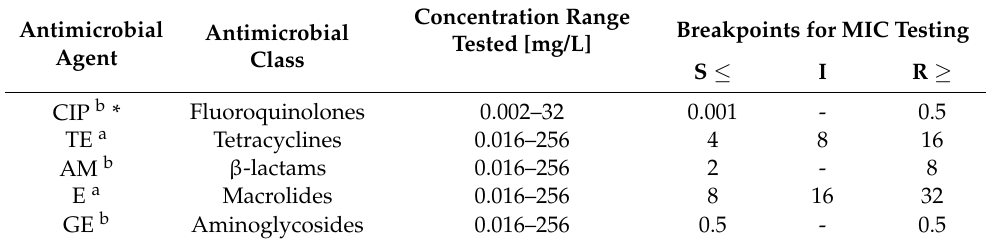
Table 4. Interpretation criteria (breakpoints) for antimicrobial susceptibility